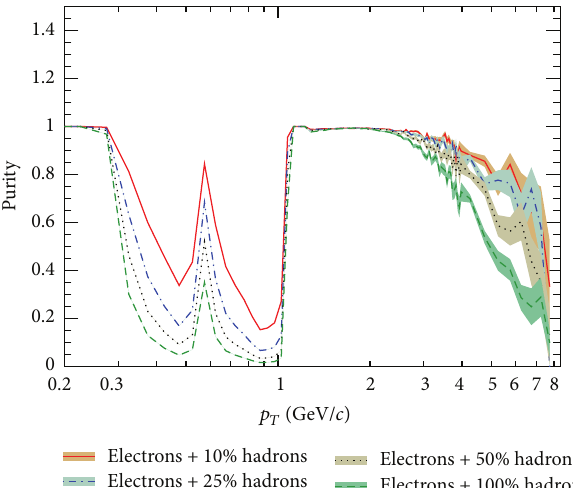
Figure 4: Purity, defined as the fraction of electrons in each particle sample in the analysis, for different hadron misidentification levels. Table 1: Signal in the 𝐽/𝜓 mass range of 2.7 < 𝑚 𝑒 + 𝑒 − < 3.3 GeV/ 𝑐 2 for various hadron contamination levels. Signal 𝑆/𝐵 ratio Significance Goodness of fit: 𝜒 2 /NDF Electrons only 1525 ± 50 4.3 32